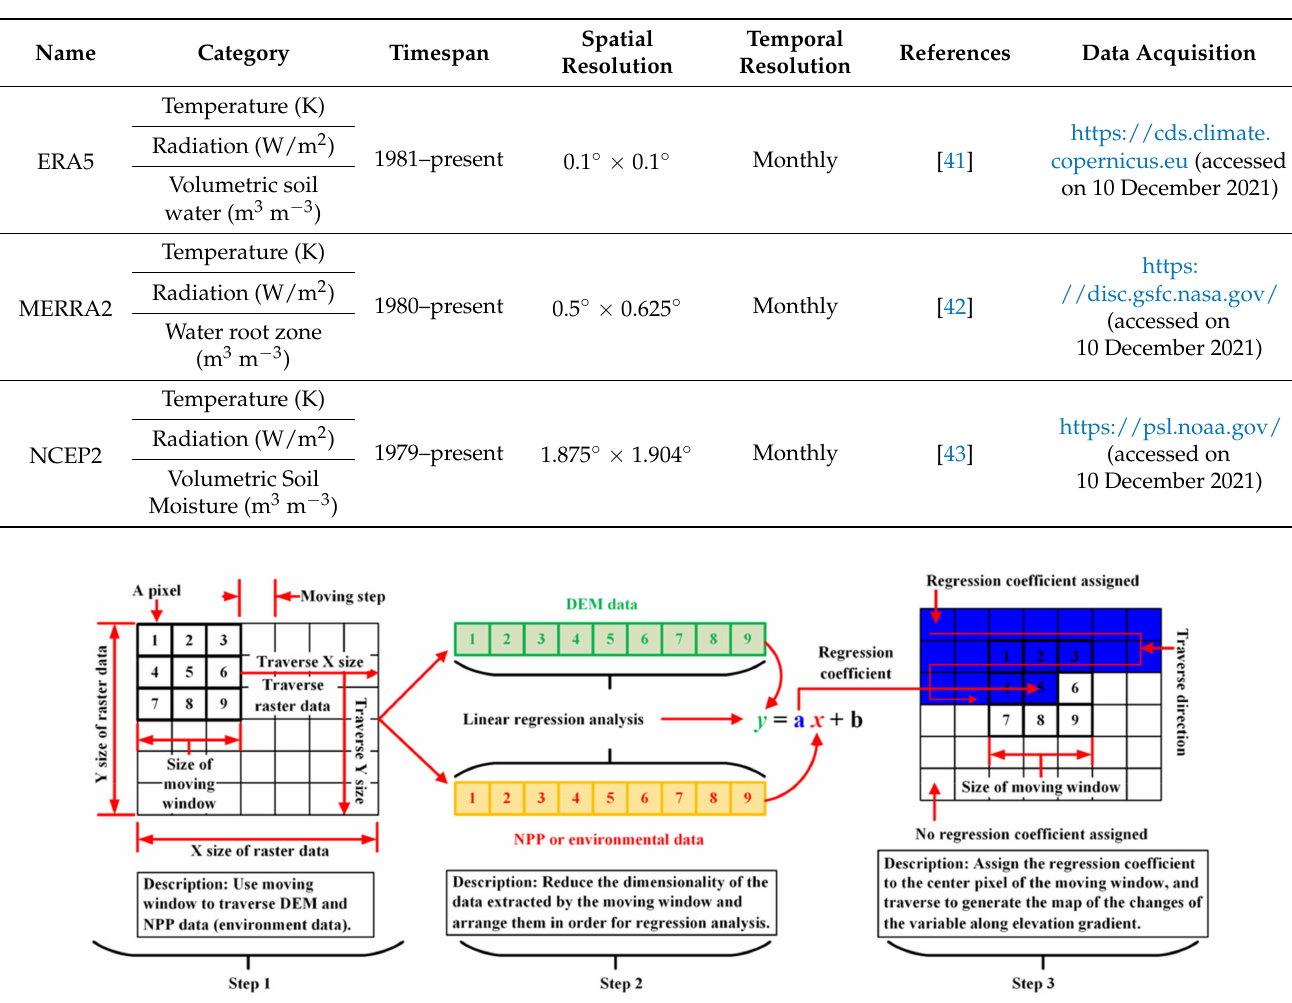
Table 1. Summary of reanalysis data products used in this study.